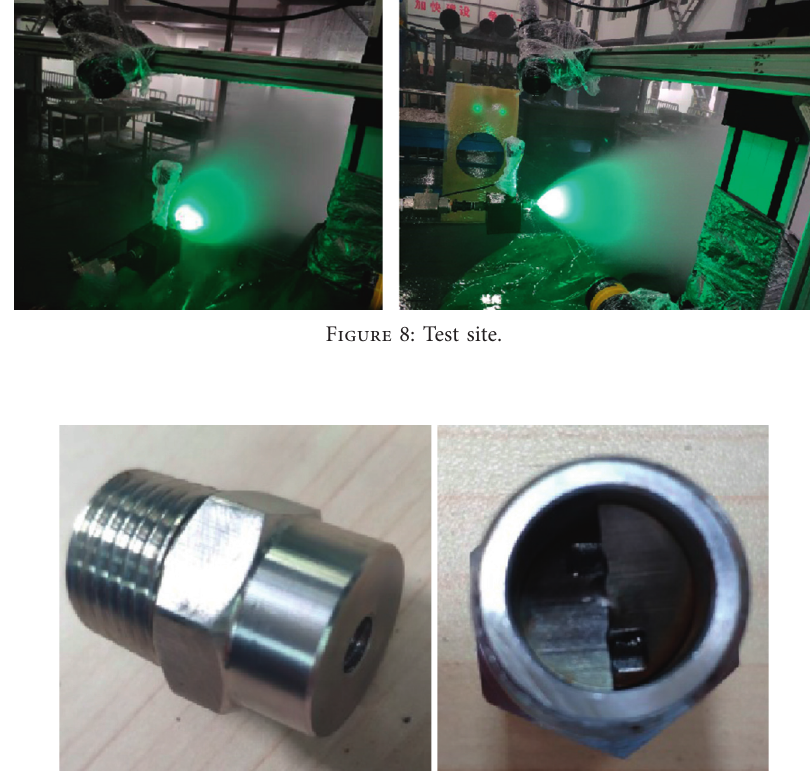
Figure 9: Photograph of the atomizing nozzle.